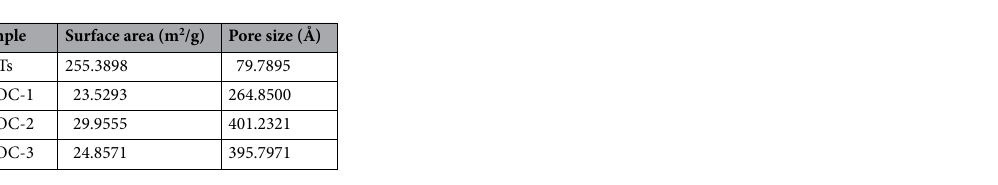
Table 1. BET surface area and pore size of the pristine CNTs and the nanocomposites.